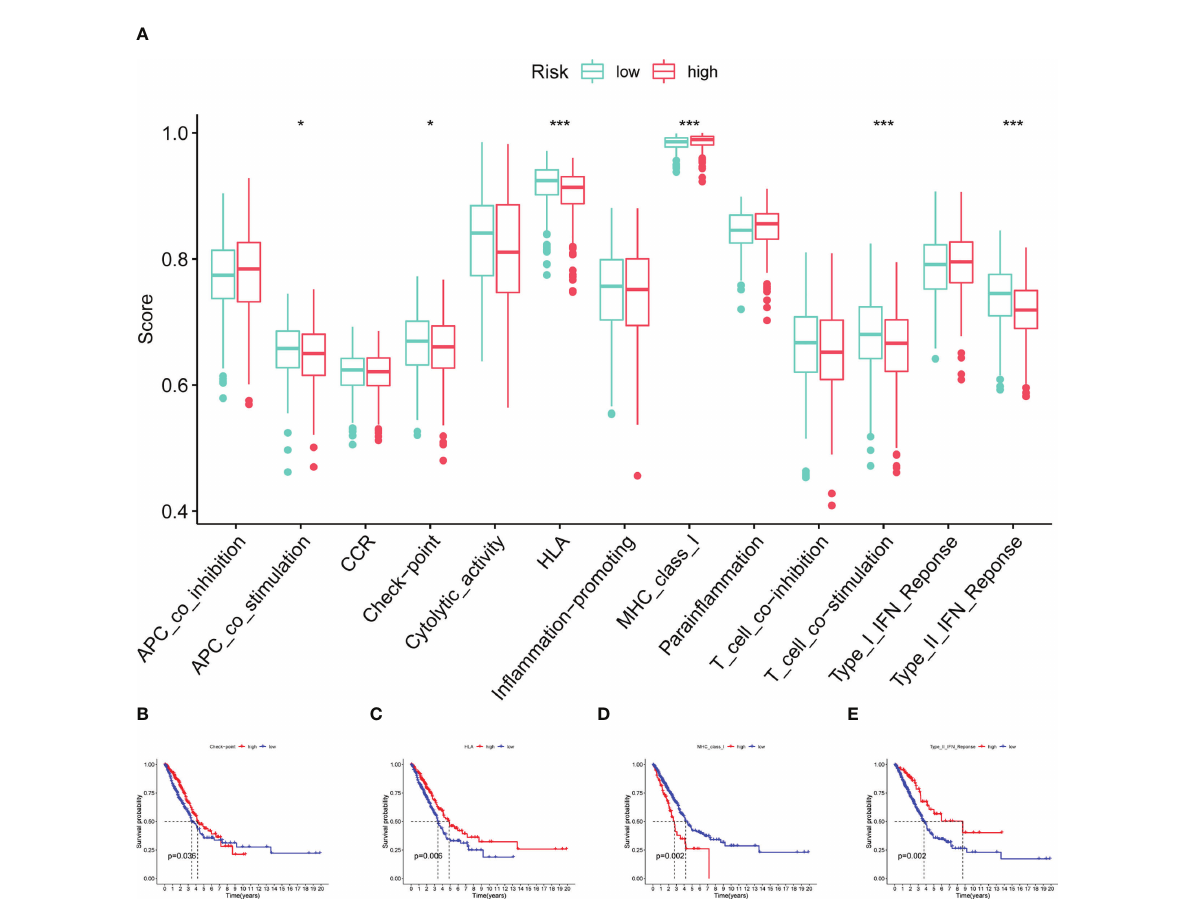
FIGURE 9 Immune function analysis. (A) Boxplot showing the relationship between four model CRs and 13 immune functions. (B – E) Survival analysis for checkpoint, HLA, MHC class I and type II IFN response (*p< 0.05; ***p<